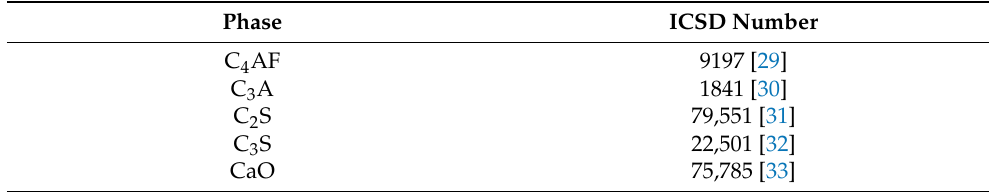
Table 5. ICSD numbers of mineral